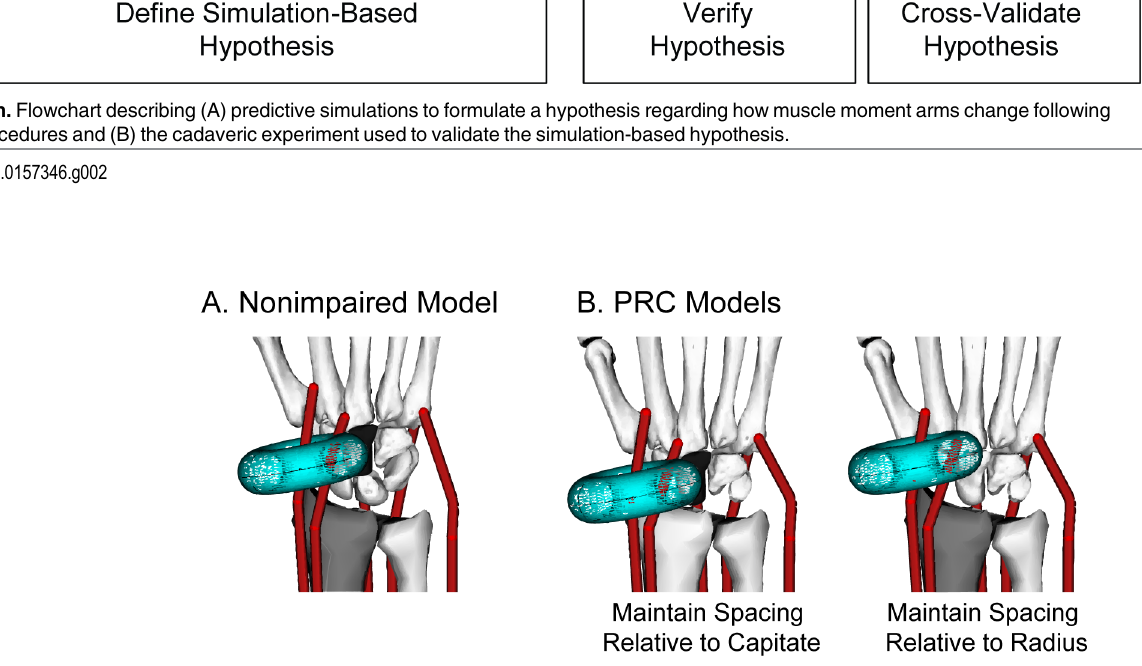
PLOS ONE | DOI:10.1371/journal.pone.0157346 June 16,